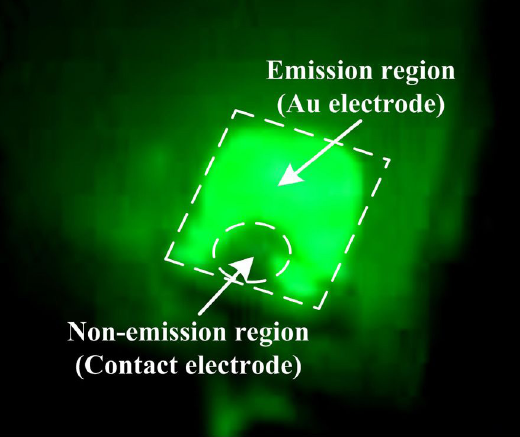
Figure 10. Luminescence image of green phosphor excited by the emission electrons from an SRSO-film cathode (Sample